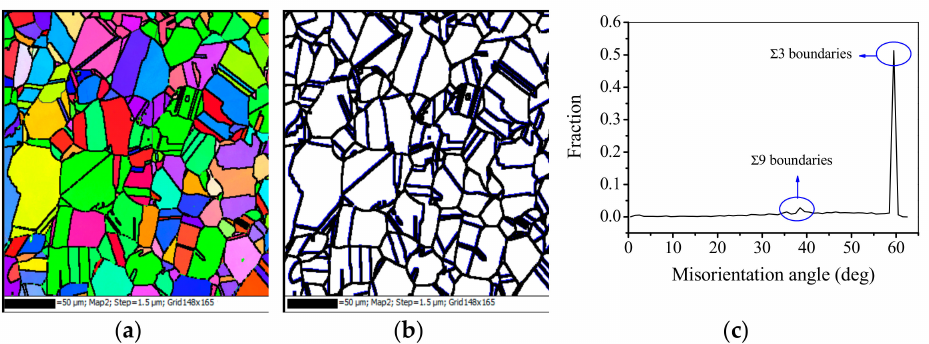
Figure 1. Microstructure of the studied superalloy before hot deformation: ( a ) orientation image microscopy map; ( b ) grain boundary distribution (LAGBs, HAGBs, and annealing twin bound- aries are indicated by thin-gray, thick-black, and thick- blue lines, respectively); ( c ) misorientation angle